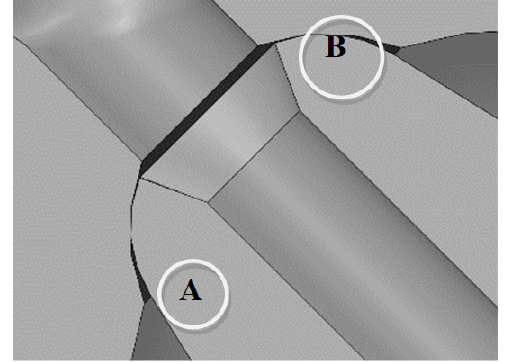
Figure 13. Contact points between BFP and the ZIN inject– tion contact zones.